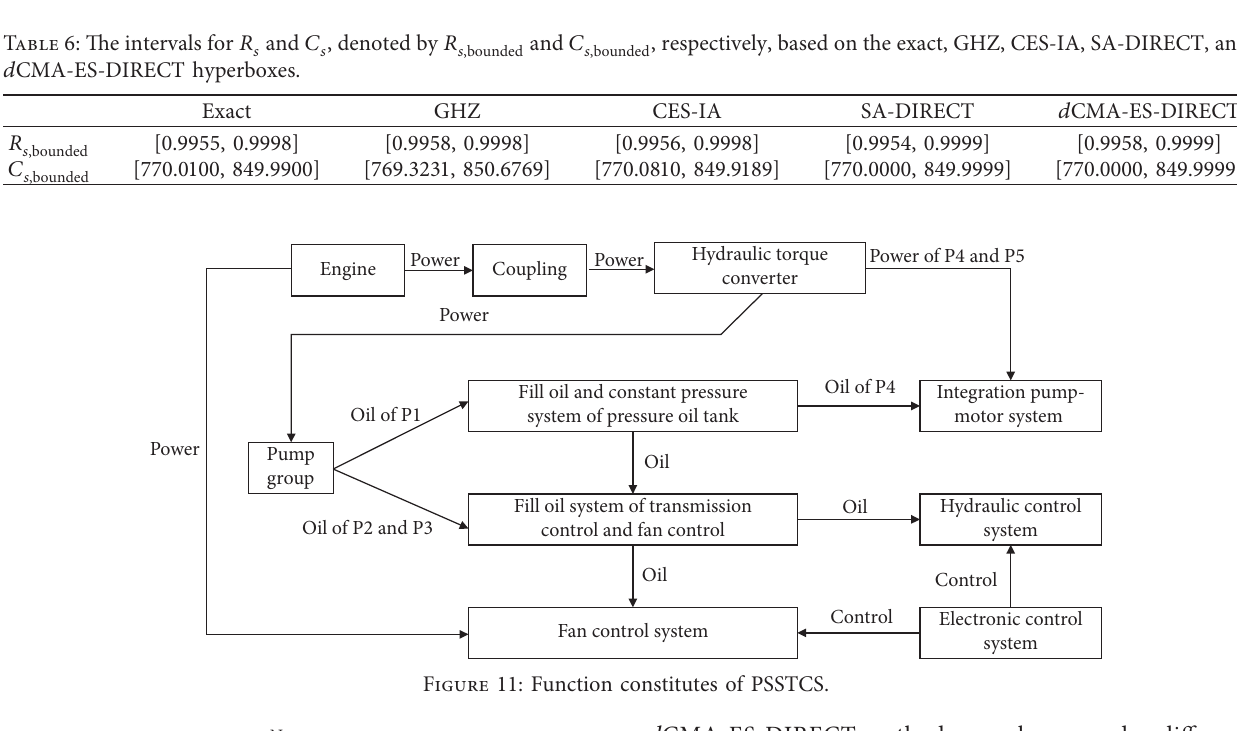
Table 5: Comparison II: the exact, GHZ, CES-IA, SA-DIRECT, and d CMA-ES-DIRECT solutions. Exact